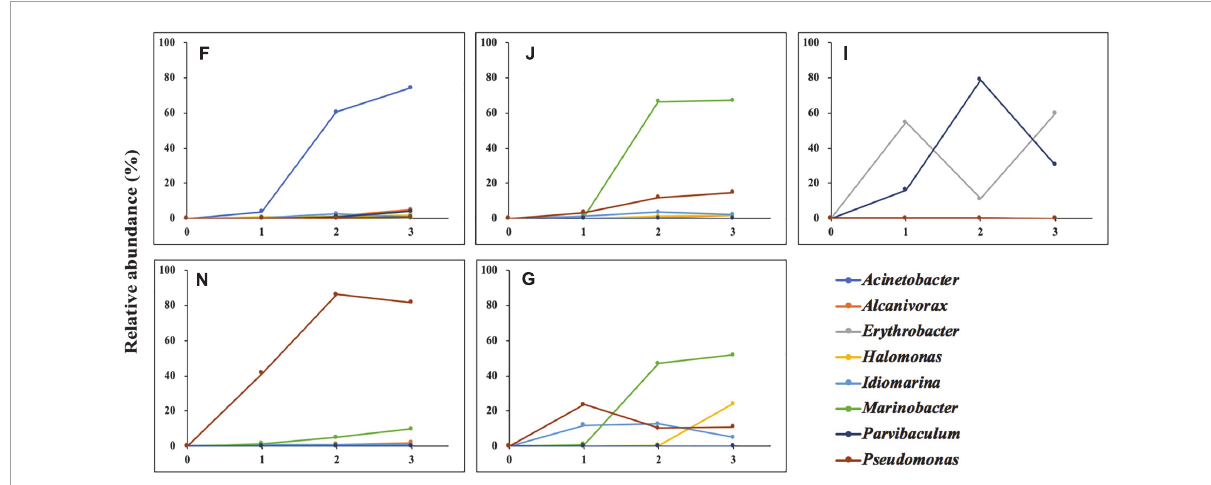
FIGURE4 Variations in the relative abundance of the dominated genera of five oil-degrading consortia during the whole enrichments. 0, 1, 2, and 3 represent cultures before, after the first, after the second, and after the third enrichment. F, J, I, N, and G refer to five different cultures derived from five surface sediments. 100% is the total abundance of all species for each